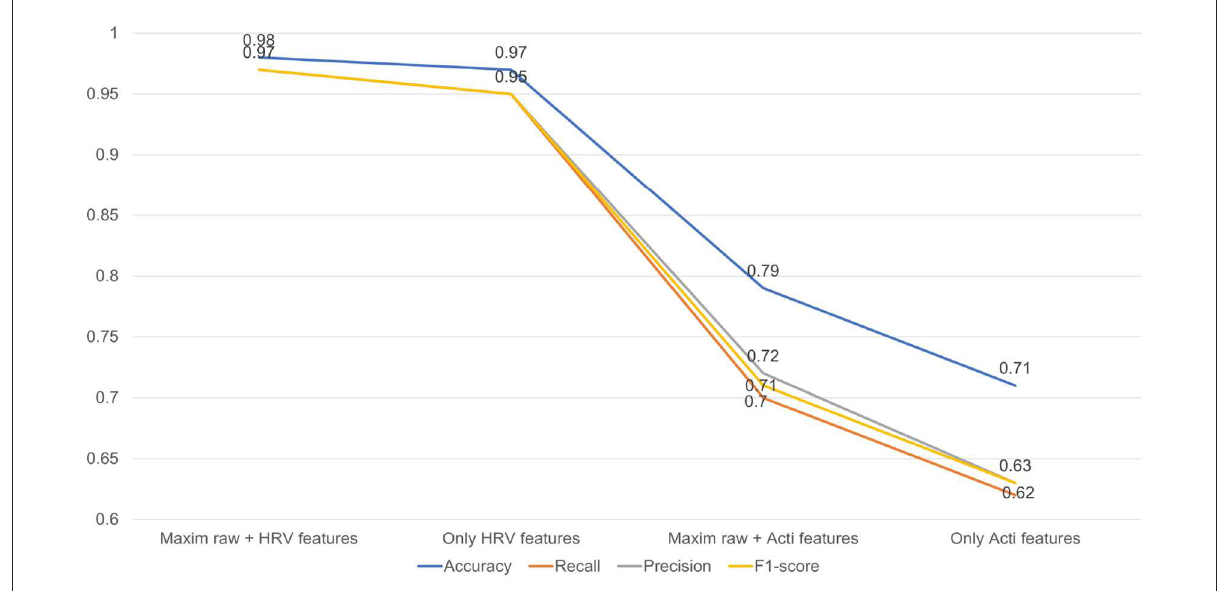
FIGURE4 Performance of four machine learning modelings were depicted as a line graph.